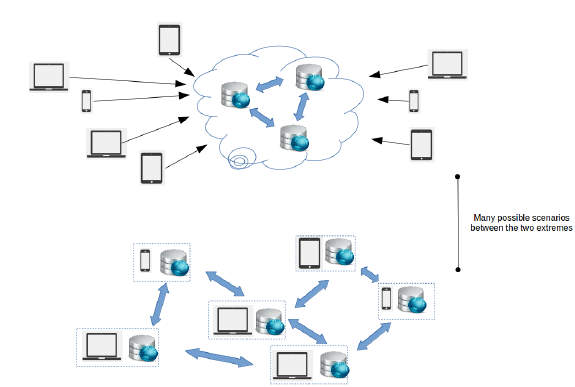
Figure 8. Maintaining consistent states by comparing private and shared data structures.